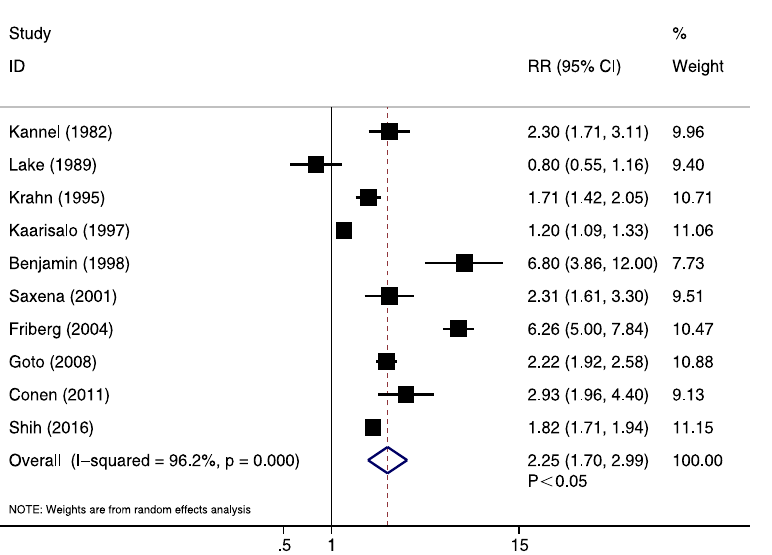
Figure 3. Forest plot showing the comparison between AF and non-AF patients in the pooled analysis of adjusted relative risk for myocardial infarction.